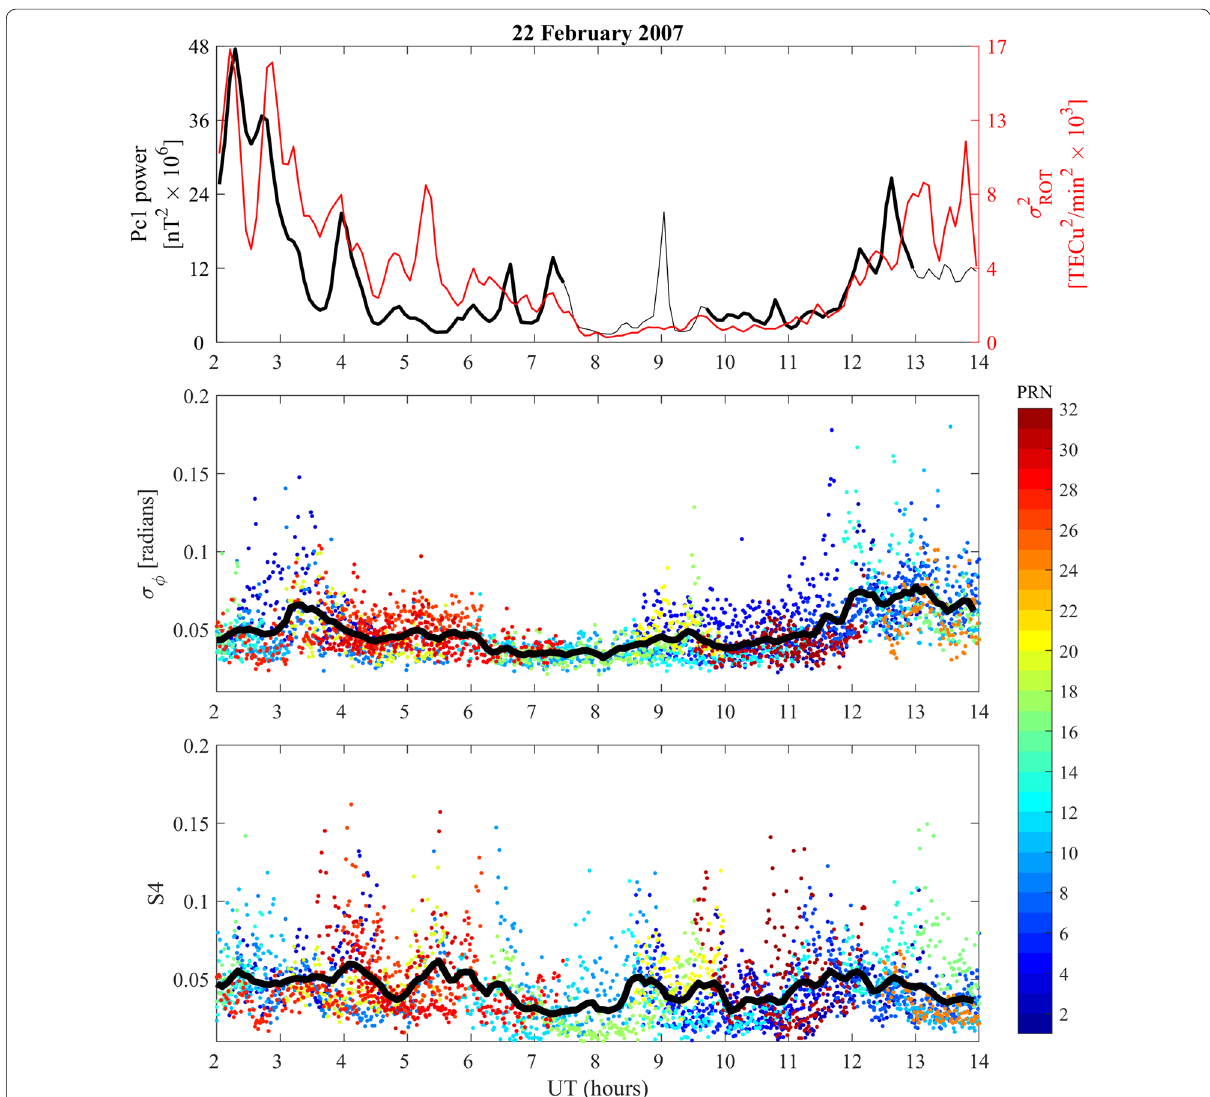
Fig. 4 Top panel: the Pc1 pulsation power (thin black line) and the average variance of ROT (red line) on 22 February 2007. The thick black line highlights the pulsation power in correspondence to the time intervals characterized by an SNR greater than 3. Middle and bottom panels show respectively the 1-min phase σ φ and the amplitude S 4 scintillation indexes on 22 February 2007 (different colors represent different satellites in the field of view of MZS; the black line is the 5-min